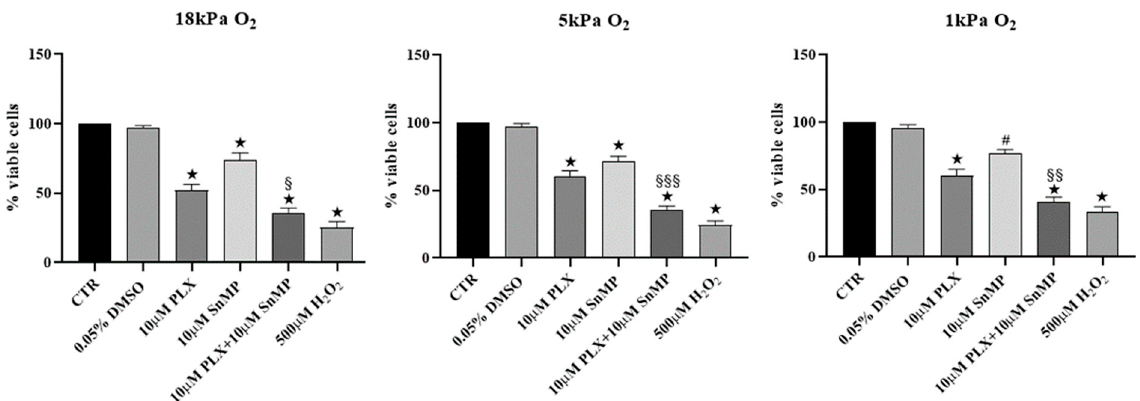
Figure 2. Melanoma cell viability after PLX4032 treatment and HO-1 inhibition. Cell viability was determined using the MTT assay in MeOV-1 cells seeded into 96-well plates and adapted for 5 days to 18 kPa O 2 , 5 kPa or 1 kPa O 2 . Cells were then treated with 10 μ M PLX4032, 10 μ M SnMP and combined treatment for 24 h. Data denote mean ± S.E.M., n = 5 independent cell cultures, (cid:70) p < 0.005 vs. respective CTR and DMSO; # p < 0.05 vs. respective CTR and DMSO; § p < 0.05 vs. respective PLX4032; §§ p < 0.005 vs. respective PLX4032; §§§ p < 0.001 vs. respective PLX4032.